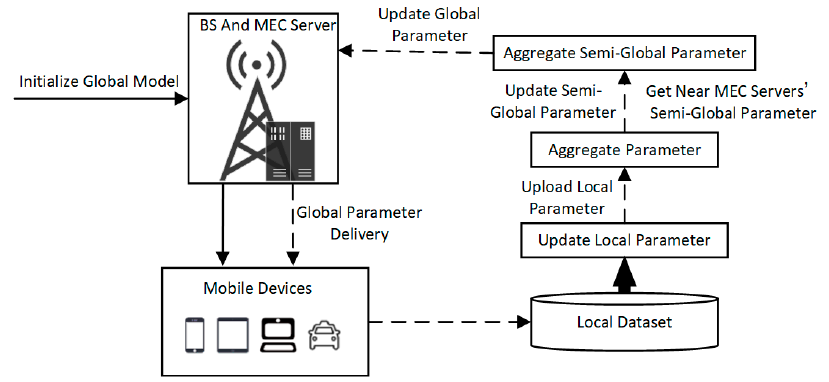
Figure 3. Federated learning system workflow for multi-agent training.